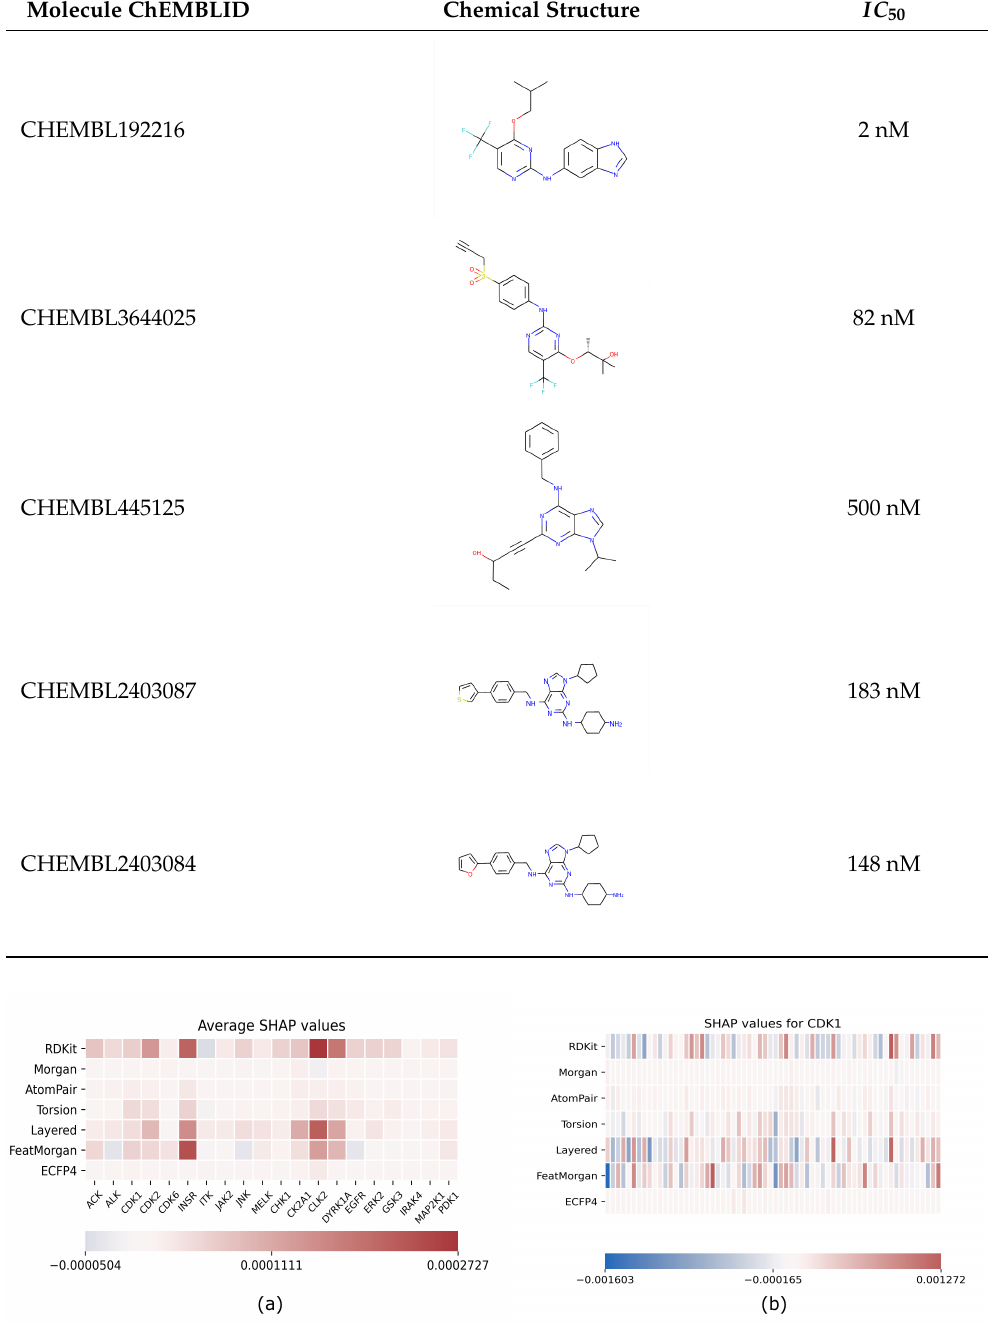
Table 3. The top five test set molecules prioritized by our classifier as the most active on the CDK1 target.